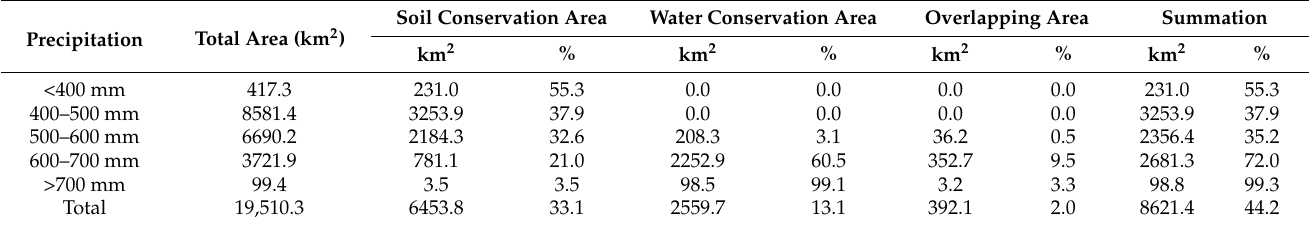
Table 3. Ratio of soil and water conservation functional areas in the city in different precipitation